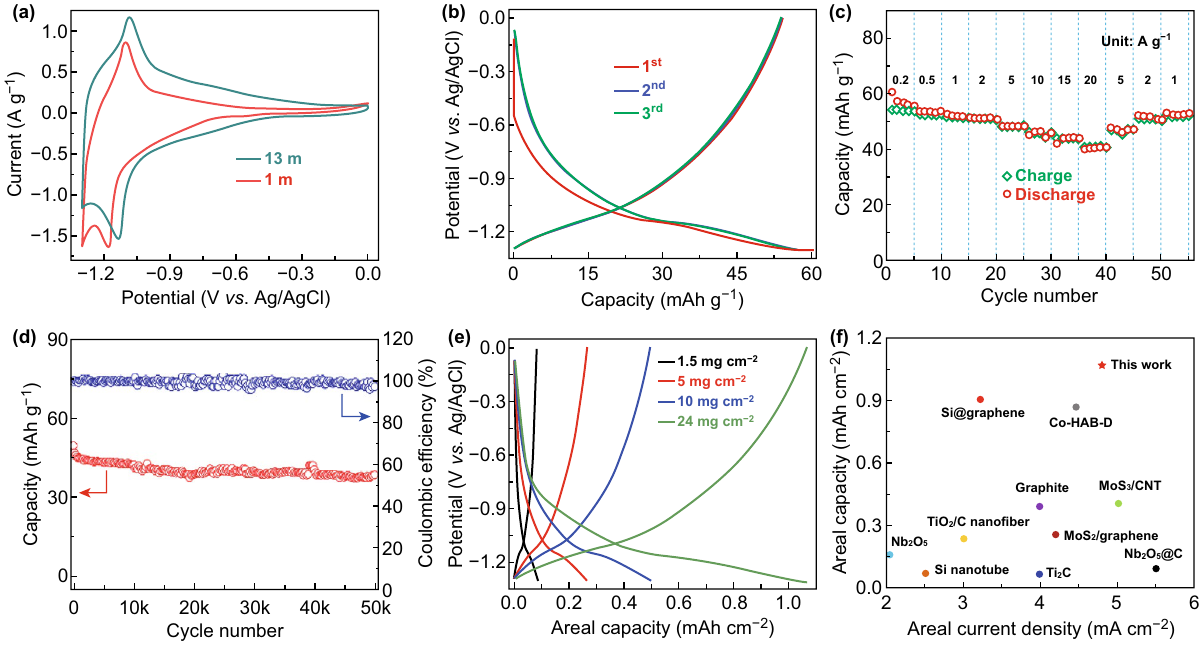
Fig. 3 Lithium-ion storage performance of NbWO electrode. a Typical CV curves in 1 m and 13 m LiAc electrolytes at 2 mV s −1 . b GCD curves at 200 mA g −1 . c Rate performance. d Cycling stability at 2 A g −1 . e GCD curves with various active mass loadings. f Areal capacity comparison of the NbWO electrode with representative anode materials for non-aqueous energy storage in previous